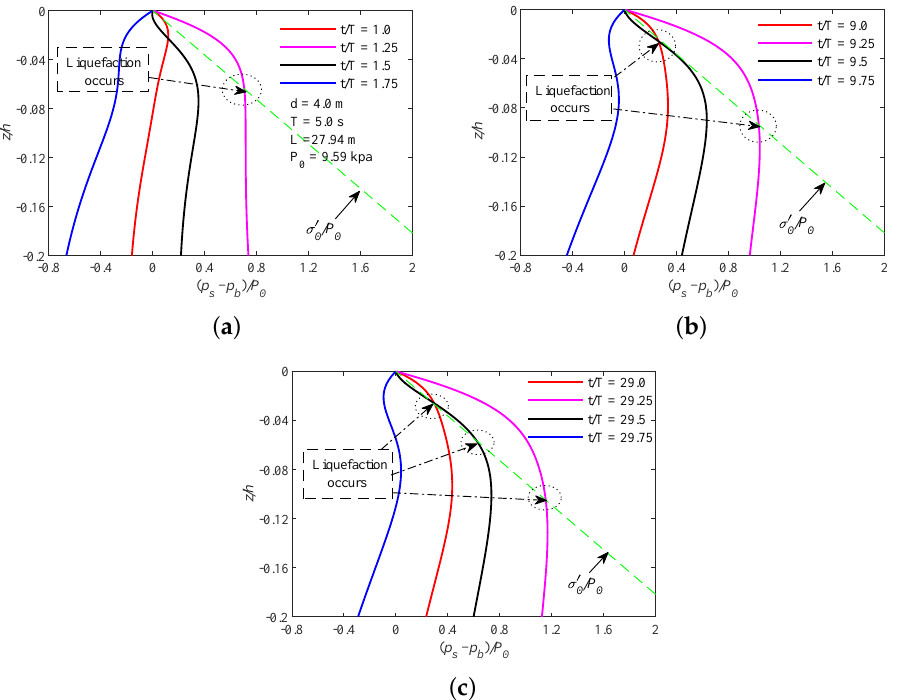
Figure 10. The oscillatory-dominant liquefaction potential (Case 1); ( a ) The 2nd wave cycle; ( b ) The 10th wave cycle; ( c ) The 30th wave